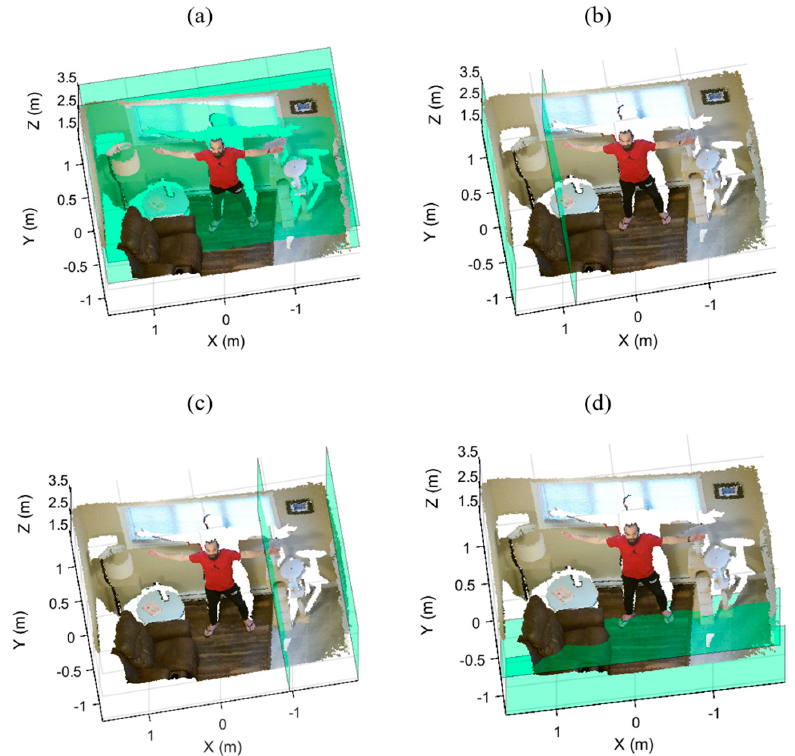
Figure 3. The boundaries of the four local regions highlighted in green: ( a ) the back, ( b ) left, ( c ) right,